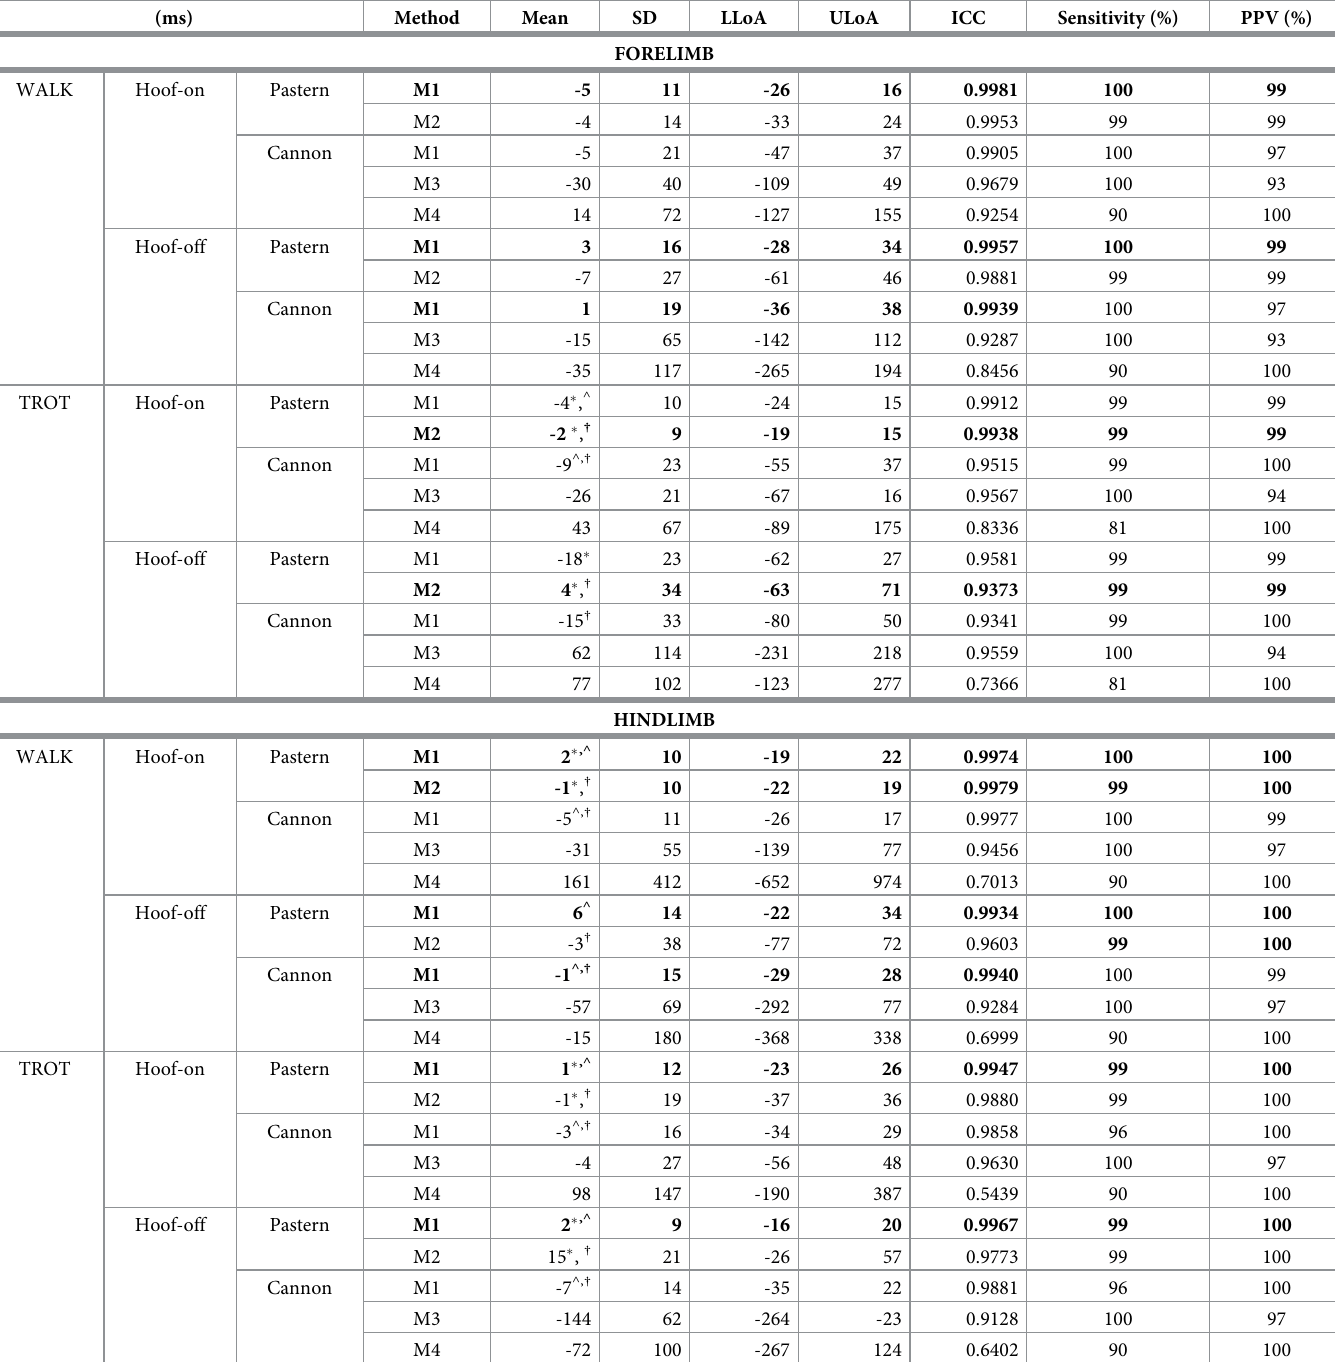
Table 2. Descriptive statistics of errors incurred by each method to detect gait events.